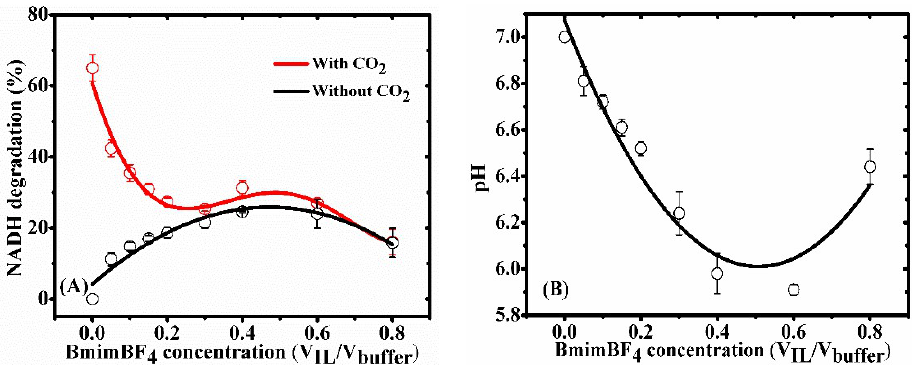
Figure 5. Effect of CO 2 on the degradation of NADH in BmimBF 4 . ( A ) Degradation of NADH with CO 2 and without CO 2 ; ( B ) pH of solution at different concentrations of BmimBF 4 ; General conditions: NADH in contained-BmimBF 4 buffer for 3 h at 37 °C; NADH (1.4 mg, 2 μmol); CO 2 (1 bar); Buffer (2 mL).